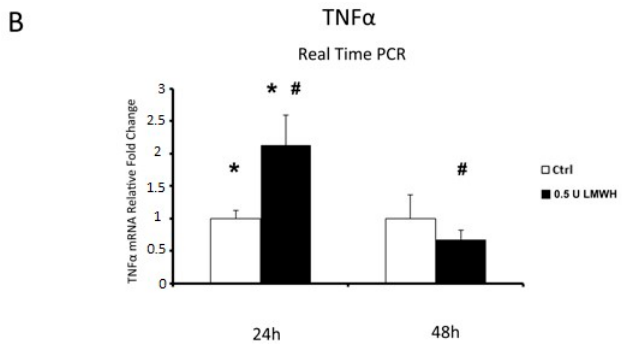
Figure 6. IL-6 and TNF α mRNA expression in LMWH-treated explants vs. controls assessed by Real Time PCR. ( A ) IL-6 gene expression in villous explants treated by 0.5 U of LMWH for 24 h (ctrl n = 8 and 0.5 U LMWH n = 10) and 48 h (ctrl n = 11 and 0.5 U LMWH n = 10). ( B ) TNF α gene expression levels in villous explants treated by 0.5 U of LMWH for 24 h (ctrl n = 8 and 0.5 U LMWH n = 10) and 48 h (ctrl n = 11 and 0.5 U LMWH n = 10). Statistical significance (*#) has been considered as p < 0.05.